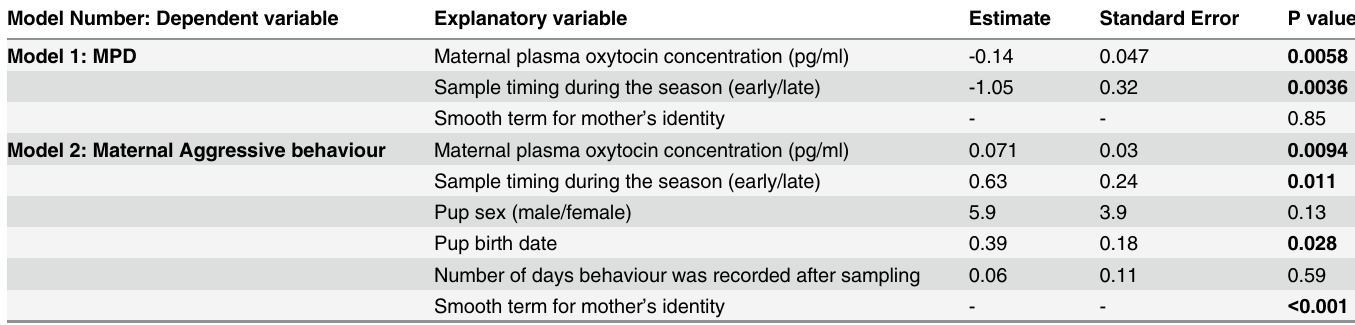
early lactation (r = 0.12, p = 0.7). Therefore, concentrations of oxytocin early in the lactation are not driving subsequent nursing intensities observed over the dependant